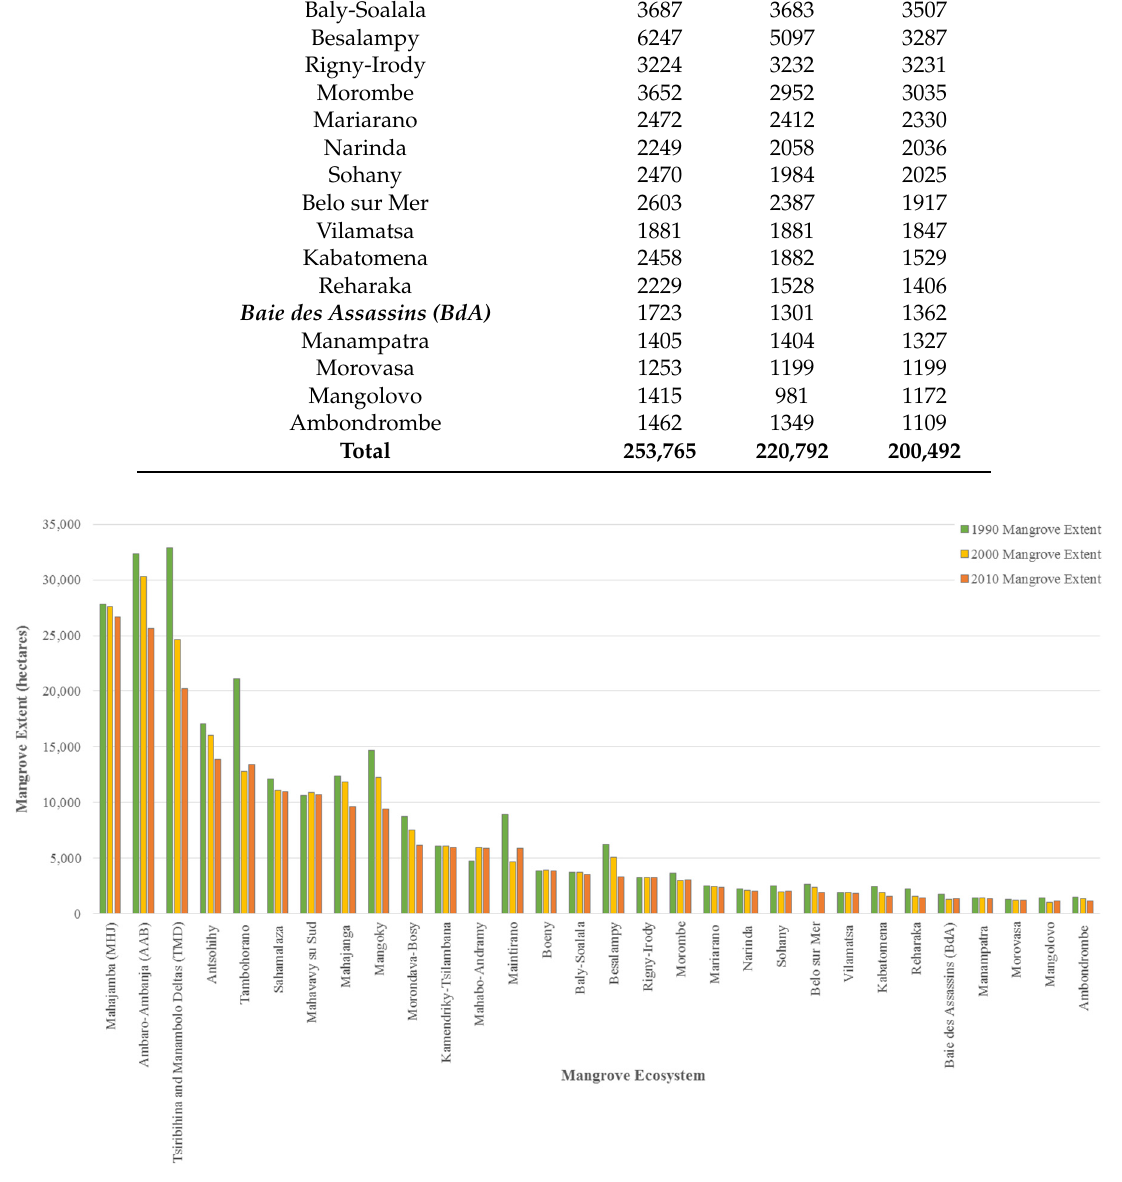
Figure 4. The extent in hectares for Madagascar’s primary mangrove ecosystems for 1990, 2000 and 2010, based on partitioning USGS-produced Landsat-derived national-level mangrove cover maps for 1990, 2000 and 2010 [69] in to primary ( i.e. , >1000 ha) mangrove ecosystems. Extents are ordered from largest to smallest based on 2010 values.